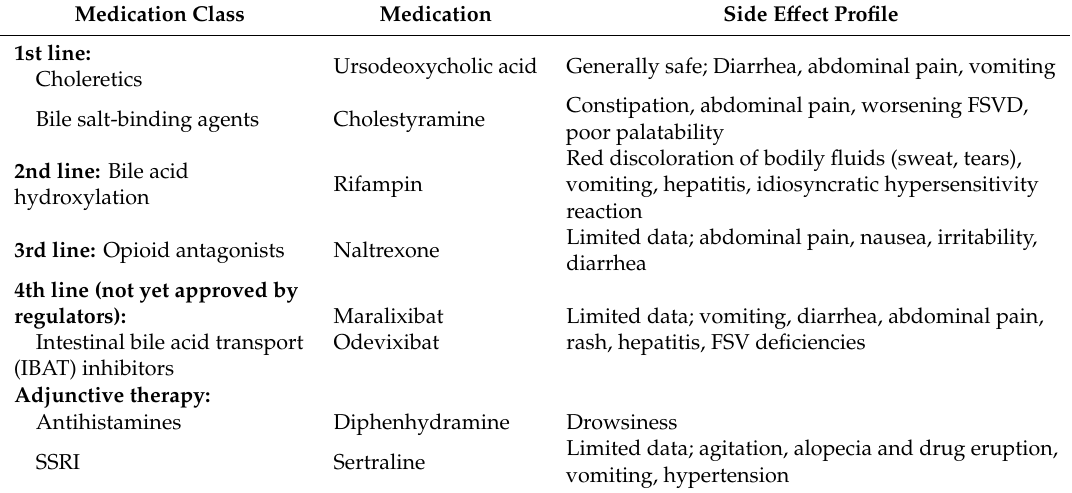
Table 2. Pharmacological step-up therapy of cholestatic pruritus in Alagille